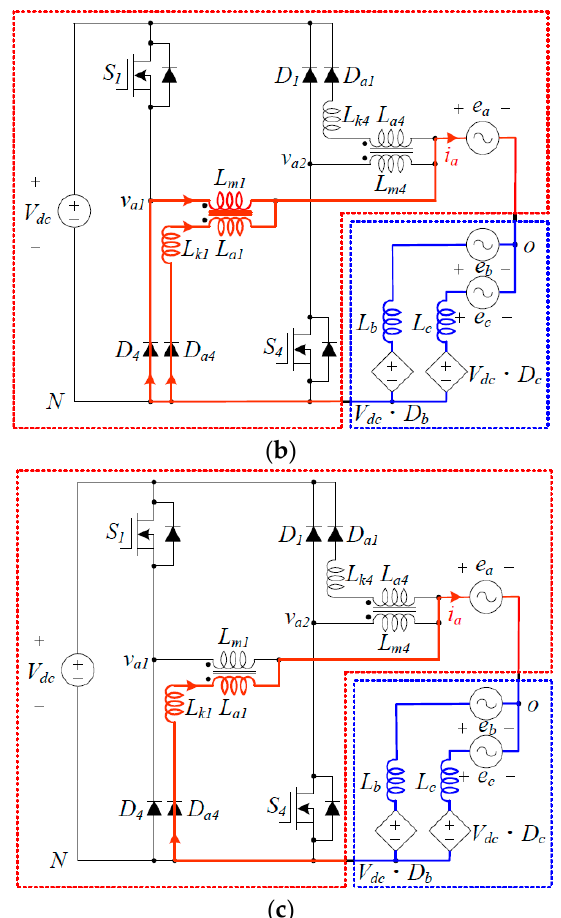
Figure 4. Switching-circuit diagrams of the proposed inverter during T s for the positive cycle of the phase voltage e a : ( a ) Stage I , ( b ) Stage II ; ( c ) Stage III .